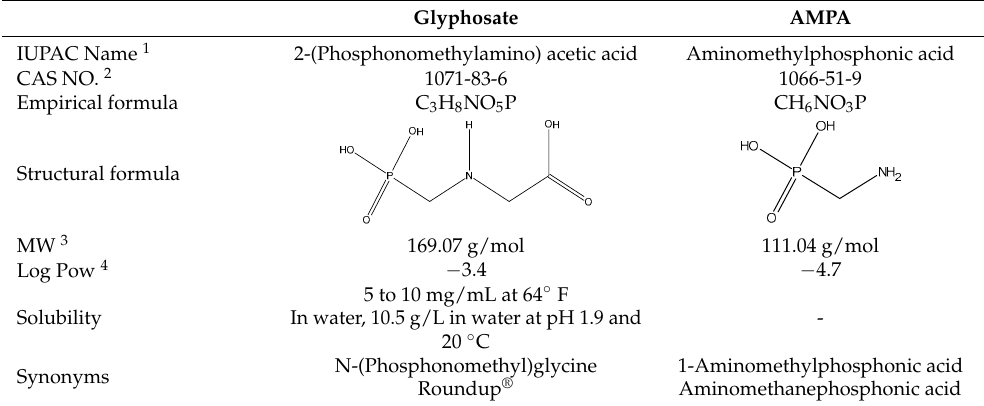
Table 1. Physicochemical properties for glyphosate and its metabolite, aminomethylphosphonic acid (AMPA).